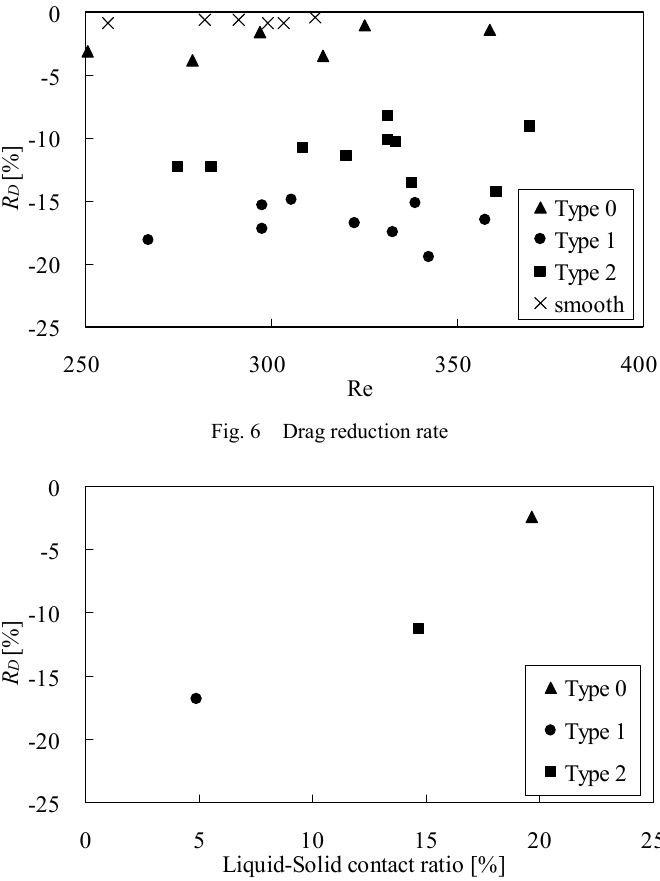
Fig. 7 Relation between drag reduction rate and wet area